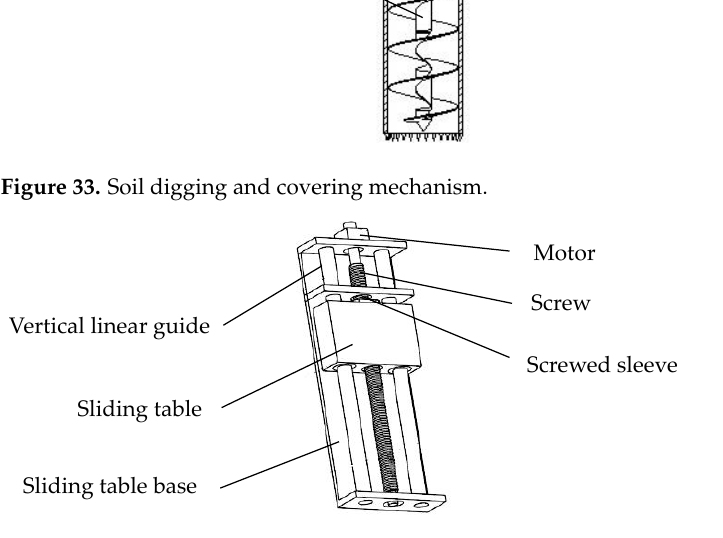
Figure 33. Soil digging and covering mechanism.